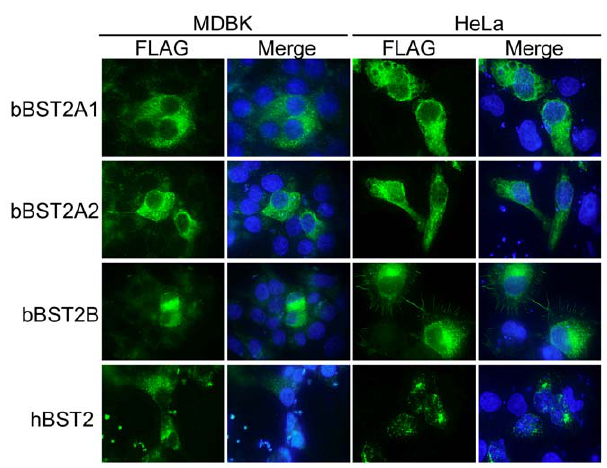
Figure 4. Subcellular localization of bovine BST-2s. FLAG-tagged bBST-2s expressed in MDBK cells (left two lines) and HeLa cells (right two lines) were stained with FITC-conjugated anti-FLAG antibody (showed green) and then observed by fluorescence microscopy. Nuclei stained with DAPI are shown in blue the merged panels.